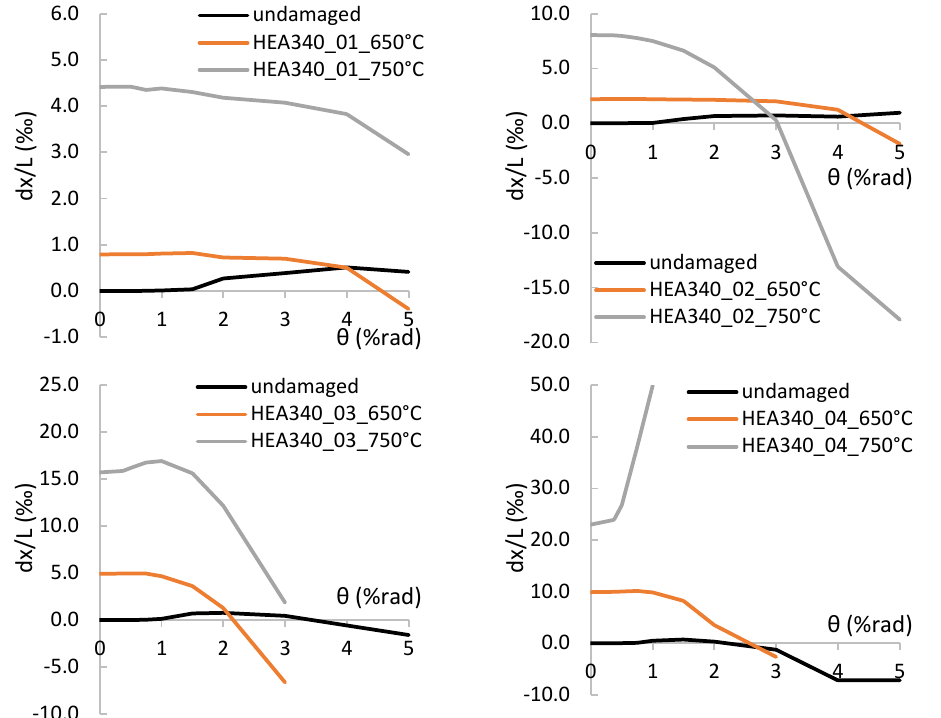
Figure 16. Overstrength factor considering the degradation of yield strength.